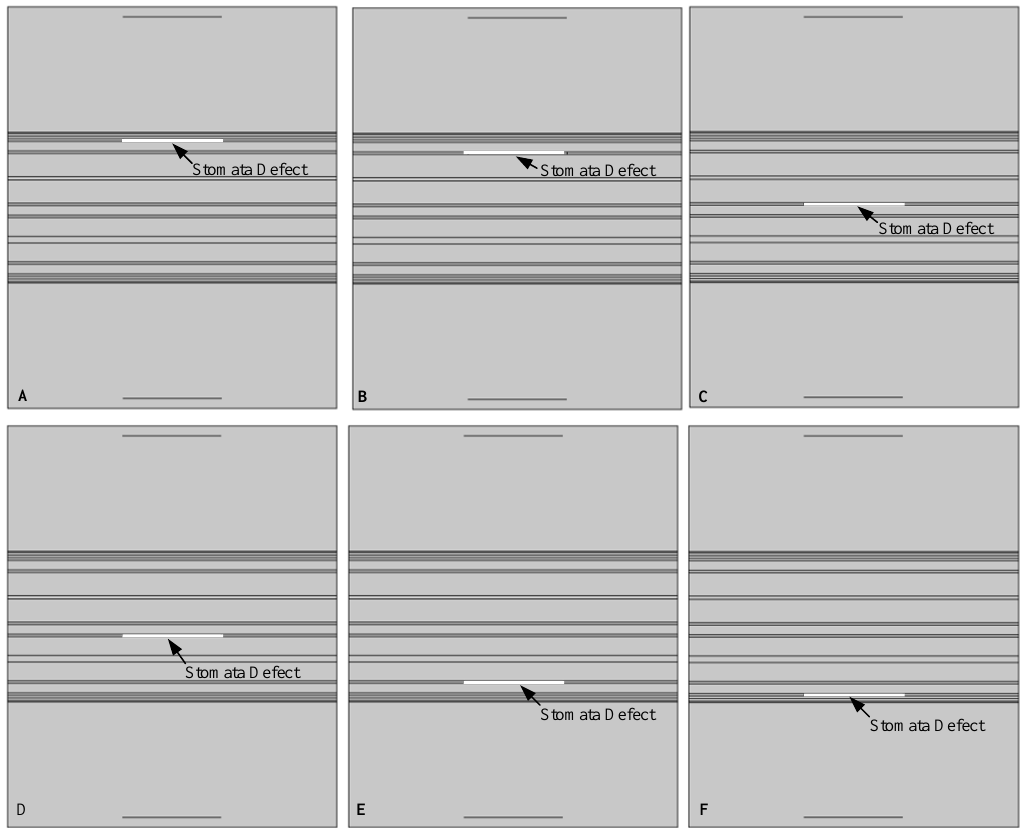
Figure 7. The defect configuration in lithium-ion battery model ( A ) First electrolyte layer; ( B ) Second electrolyte layer; ( C ) Third electrolyte layer; ( D ) Fourth electrolyte layer; ( E ) Fifth electrolyte layer; ( F ) Sixth electrolyte layer.